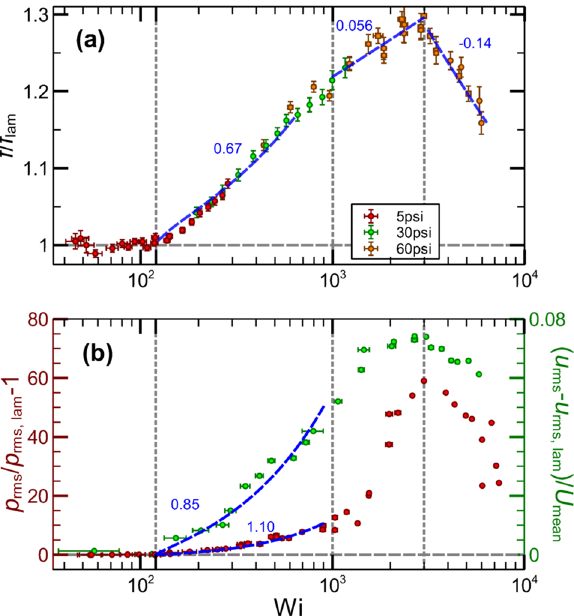
Figure 2. Properties of chaotic flows above the non-modal elastic instability in three regimes. ( a ) The friction factor ( f / f lam ) versus Wi in lin-log scales. Two individual pressure drop measurements are conducted at different positions but with the same gap: from l / h =185 to 725 and from 225 to 765, which are plotted together. Three differential pressure transducers in three ranges are used: 5 (in red), 30 (in green), and 60 (in orange) psi. ( b ) Normalized rms pressure ( p rms / p rms , lam ) − 1 and velocity ( u rms − u rms , lam )/ U mean fluctuations versus Wi in lin-log scales. The vertical three greys dashed lines separate four flow regimes determined by different scaling of the flow parameters on Wi